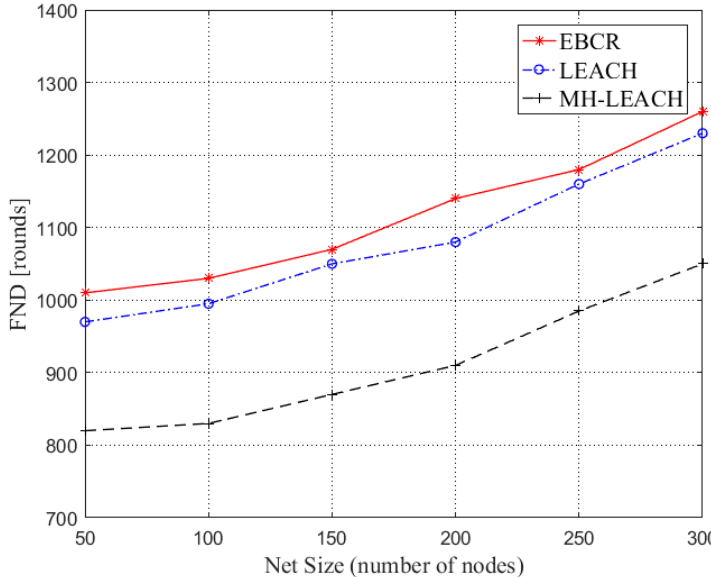
Figure 10. Comparison of the time of first node’s death.